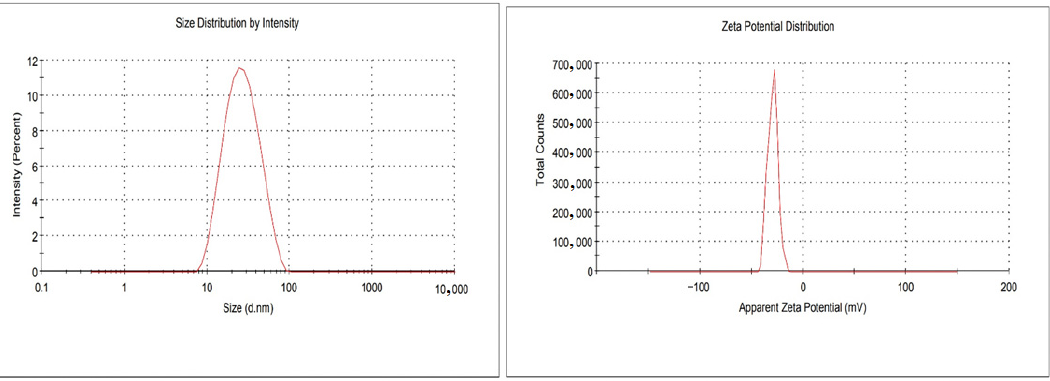
Figure 5. Globule size and zeta potential of optimized DSM-loaded NEs (F1).